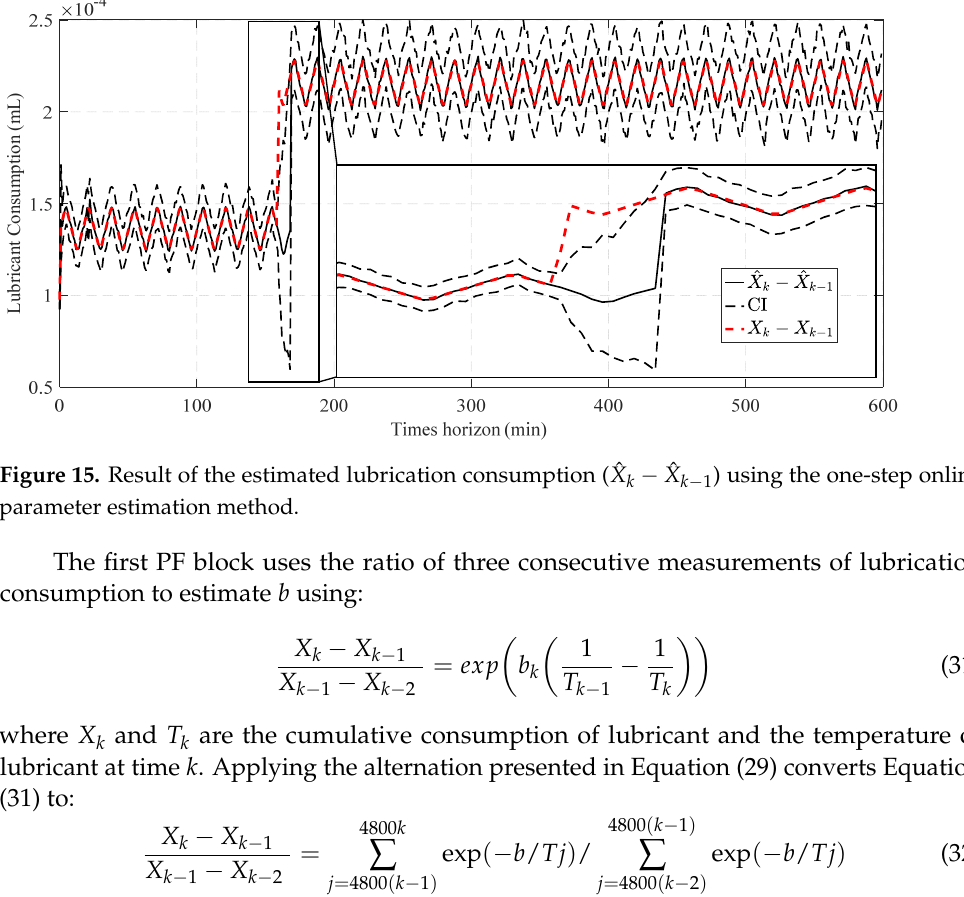
Figure 14. Flow of two-step online parameter estimation for degradation model.